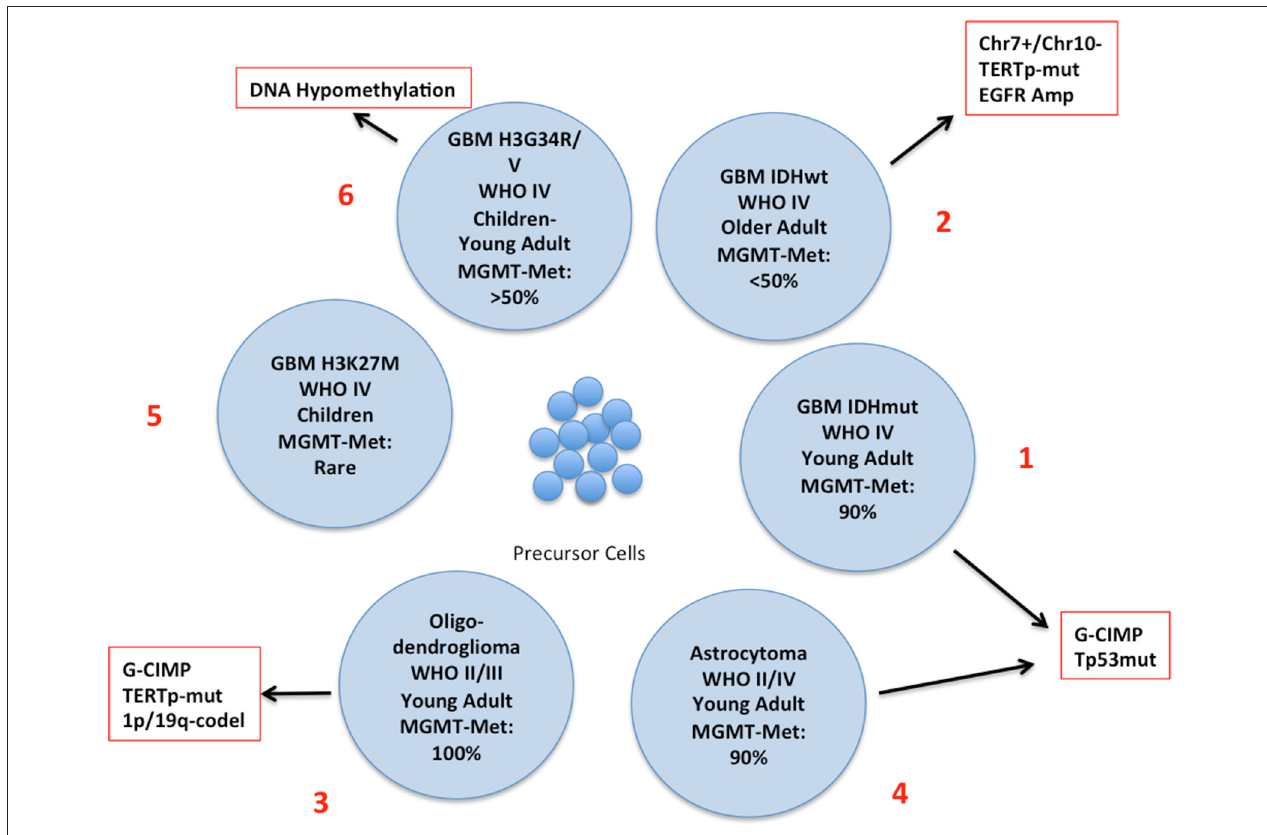
FIGURE 2 | Schematic representation of the different subtypes of glioma with the principal molecular and epigenetic characteristics. In this chart are represented the possible carcinogenic evolutions of the precursor cells. The major genetic and epigenetic alterations are reported along with the clinical characteristics of each